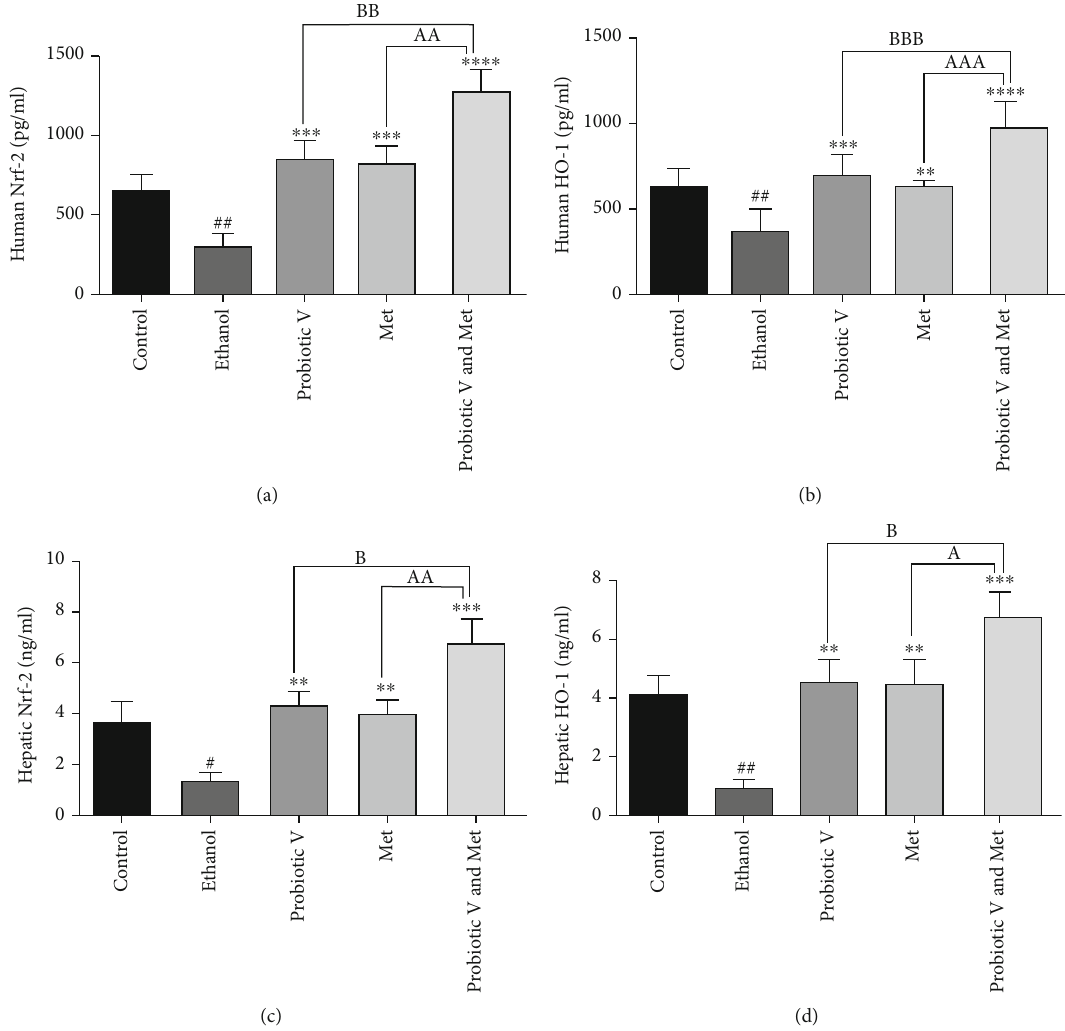
Figure 12: Protein levels of (a) human Nrf-2, (b) human HO-1, (c) hepatic Nrf-2, and (d) hepatic HO-1 analyzed through ELISA. Probiotic V and Met alone or in combination helps in regulating the production of antioxidants in HepG2 cells and Wistar rats. Values are expressed as mean ± SD of three individual experiments (HepG2 cells) and six rats. Statistical signi fi cance was assessed by one-way ANOVA followed by Tukey post hoc test. Statistical analysis: # p < 0 : 05 and ## p < 0 : 01 compared with control group; ∗∗ p < 0 : 01 , ∗∗∗ p < 0 : 0001 , and ∗∗∗∗ p < 0 : 0001 compared with ethanol group; A,B p < 0 : 05 , AA,BB p < 0 : 01 , AAA,BBB p < 0 : 001 , and AAAA,BBBB p < 0 : 0001 compared with probiotic V and Met combinatorial